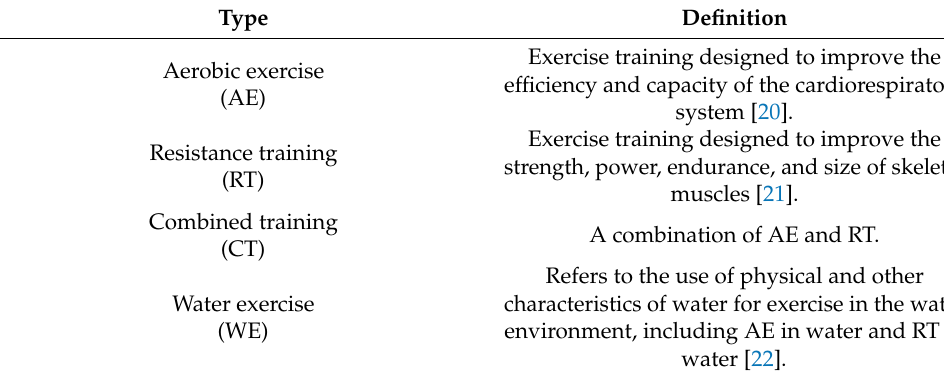
Table 1. Classifications of exercise